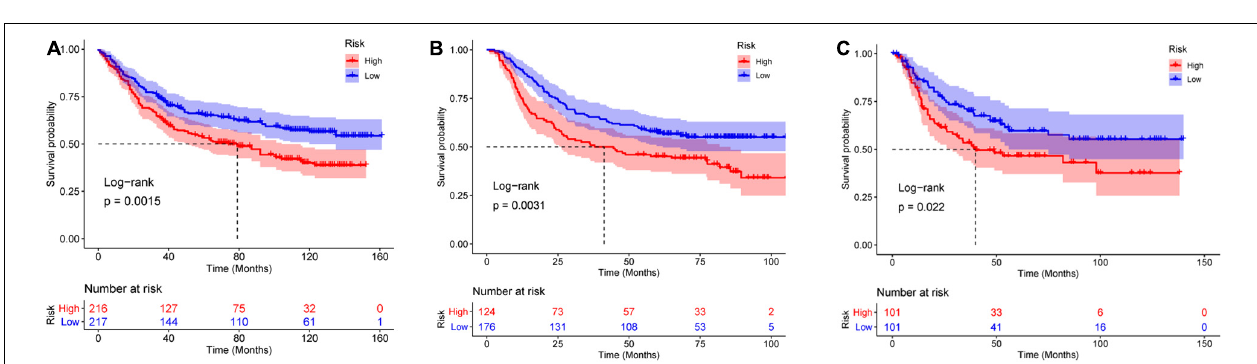
FIGURE 7 | Validation of the PRS against the (A) GSE84437, (B) GSE66229, and (C) GSE26942